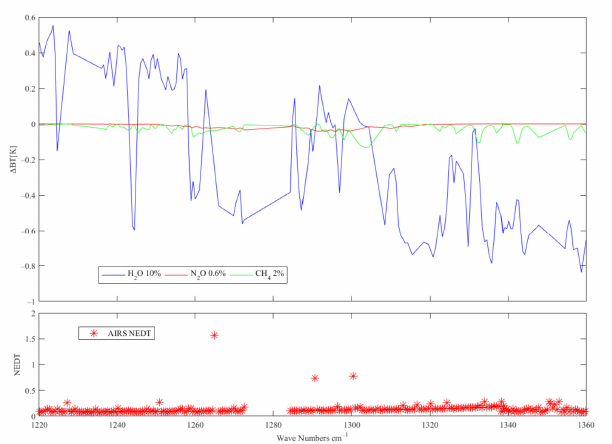
Figure 3. Changes in the BT near the υ 1 absorption band of N 2 O that occur when the water vapor, N 2 O and CH 4 concentrations increase by 10%, 0.6%, and 2%, respectively, (top) and the AIRS channel noise in the υ 1 absorption band of N 2 O